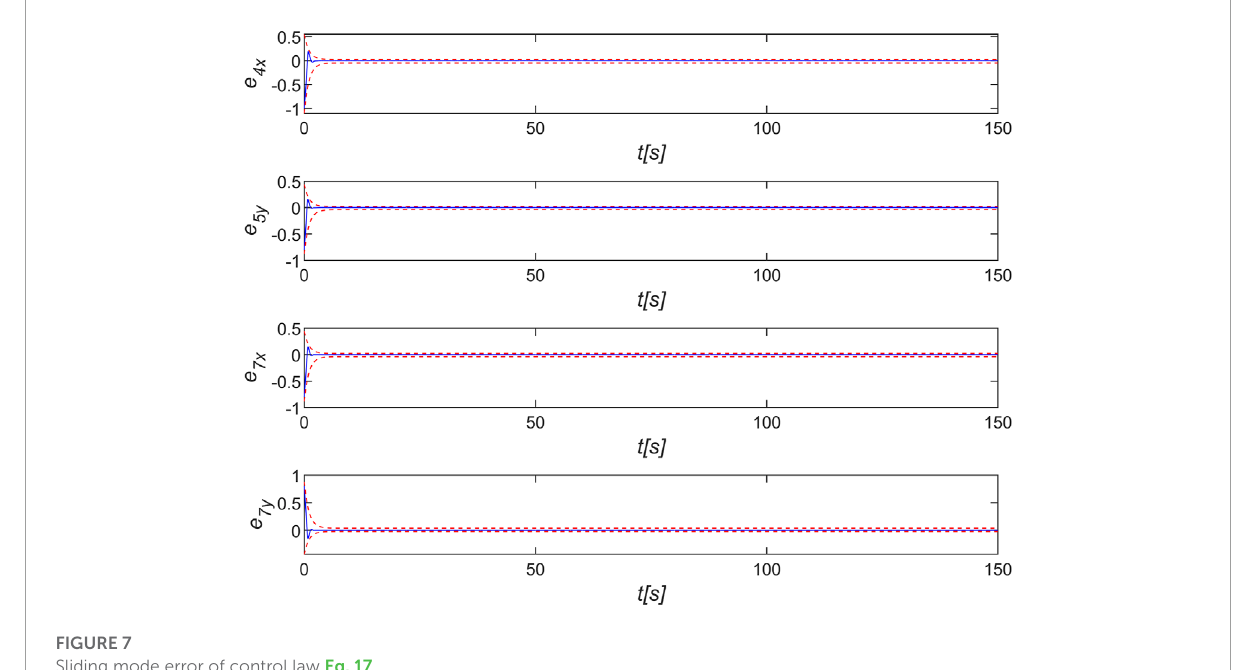
FIGURE 7 Sliding mode error of control law Eq. 17 .